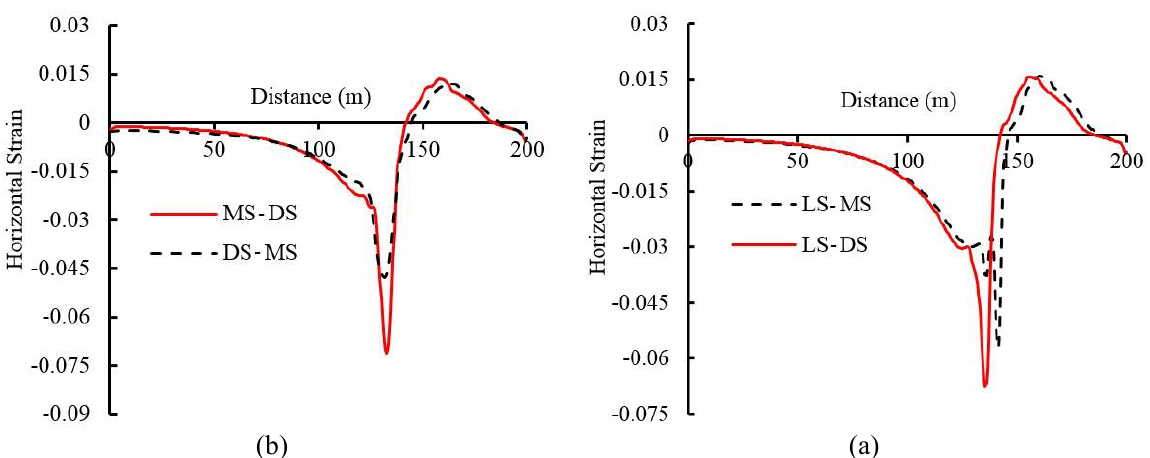
Fig. 12. horizontal strain of ground with two-layer structure: (a) LS-DS and DS-LS, (b) MS-LS and MS- DS.